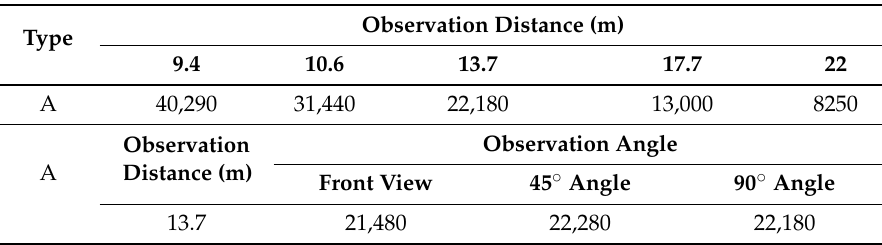
Figure 14. Detection image of Type A in the on-site test. Table 7. Photon numbers of Type A in the on-site test.